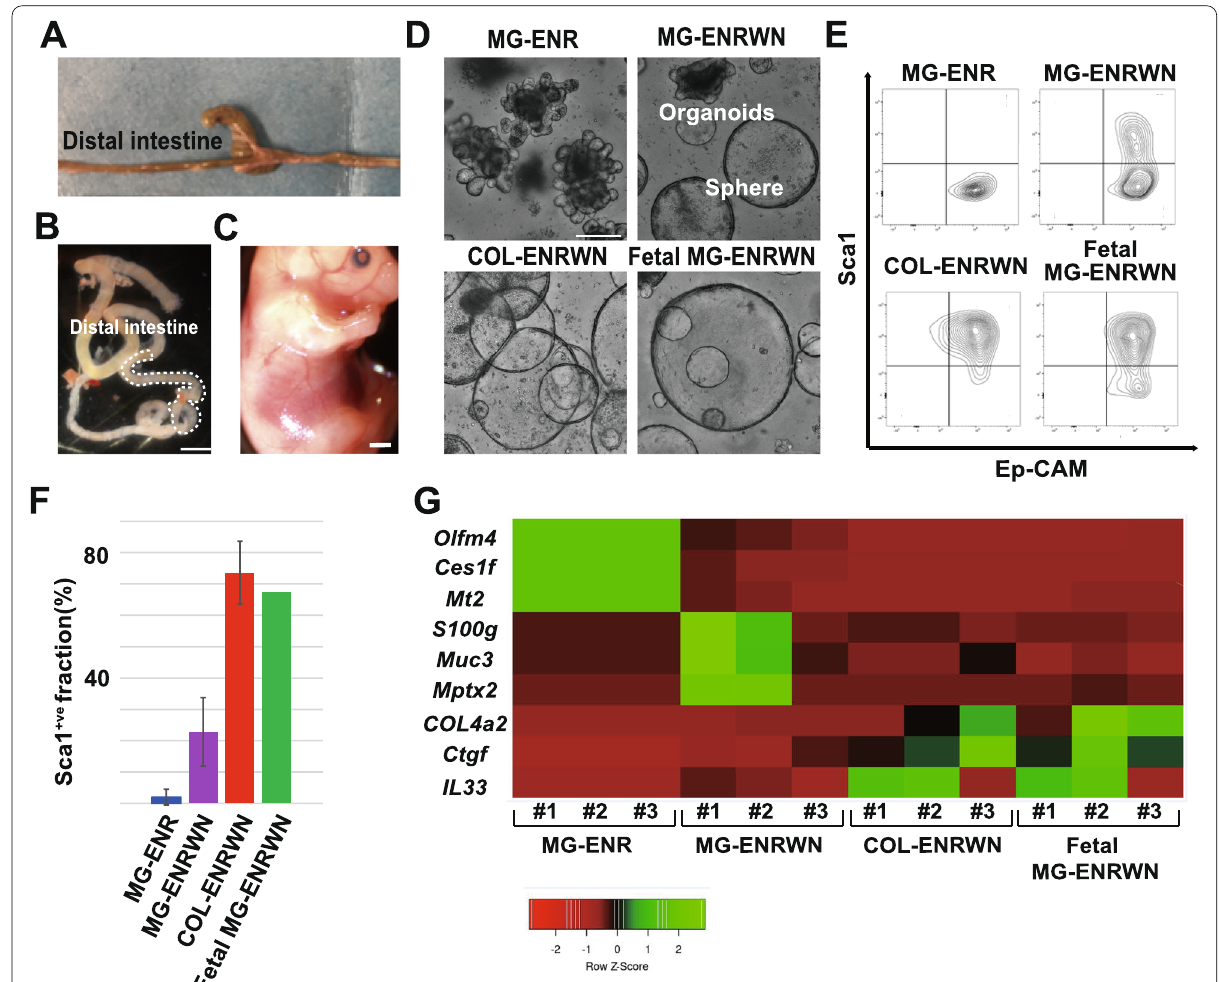
Fig. 1 Extracellular matrix (ECM) directs the acquisition of developmental and regenerative signature in vitro. A The anatomy of the murine distal small intestine to establish intestinal organoids is shown. B A macroscopic image of the fetal murine intestine used to establish dFEnS is shown. The demarcated area indicates the distal small intestine used for in vitro expansion. Scale bar, 1mm. C A macroscopic image of the fetal mouse at E16 is shown. Scale bar, 1 mm. D Representative images of adult murine distal small intestinal organoids cultured in Matrigel with ENR medium (top left panel), in Matrigel with ENRWN medium (top right panel), in collagen with ENRWN medium (bottom left panel), and fetal murine intestinal organoids in Matrigel with ENRWN medium (dFEnS) (bottom right panel). Scale bar, 200μm. E Flow cytometric analysis of cells from the intestinal organoids in MG‑ENR (top left panel), MG‑ENRWN (top right panel), COL‑ENRWN (bottom left panel), and fetal MG‑ENRWN (dFEnS) (bottom right panel) is shown. Diagrams show representative plots for Sca1 in the live EpCAM ve cell population. F The percentages of Sca1 + ve cells in MG‑ENR, + MG‑ENRWN, COL‑ENRWN, and fetal MG‑ENRWN organoids are indicated. The diagram shows the